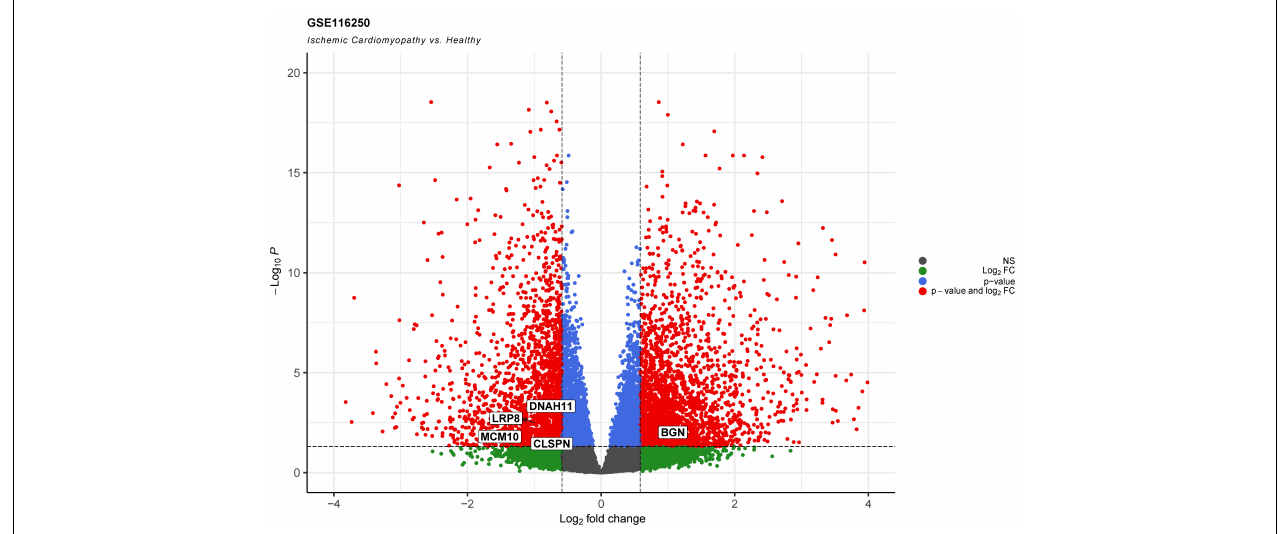
FIGURE 5 | Volcano plot showing results of differential gene expression analysis of human heart tissue from ischemic heart failure in comparison with healthy controls. Red dots show significantly deregulated genes with logFC > | 0.585| and adjusted p -value < 0.05. Genes of interest are labeled.